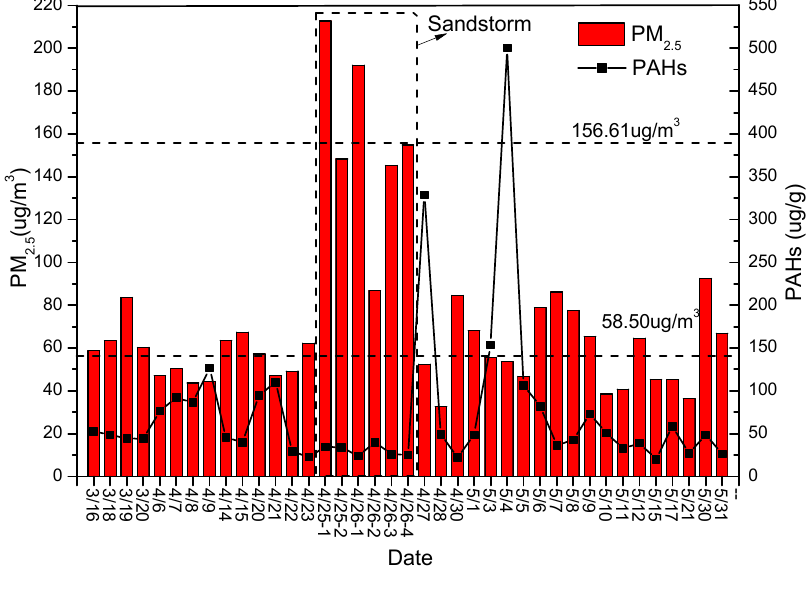
Figure 2. PM 2.5 and total daily PAH levels measured at Mount Heng. Table 1. Concentrations of the individual polycyclic aromatic hydrocarbons (PAHs) during the sandstorm (25 and 26 April 2009) and under normal conditions (no sandstorm) (µg/g).